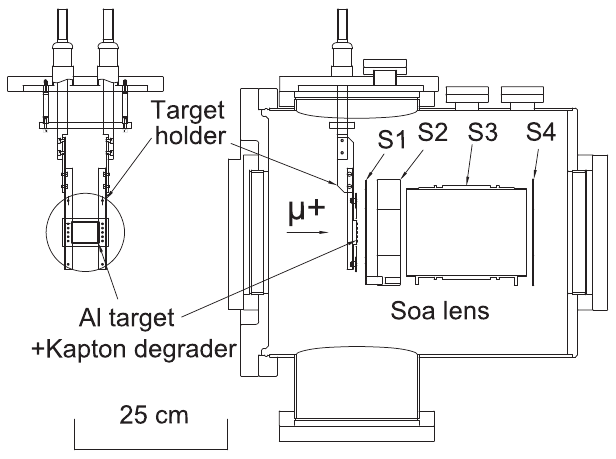
FIG. 2. Schematic drawing of the Al target and the Soa